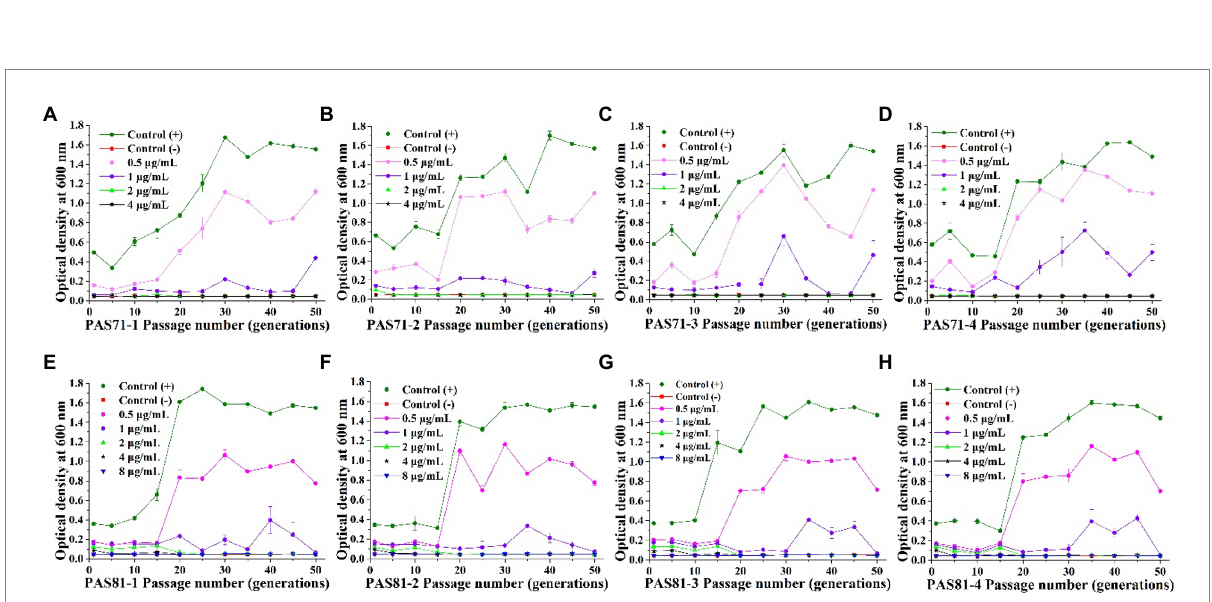
FIGURE 3 Curves of levofloxacin resistance of the four subpopulation isolates of PAS71 and PAS81 after 50 generations of subcultures without antibiotics. (A) PAS71-1; (B) PAS71-2; (C) PAS71-3; (D) PAS71-4; (E) PAS81-1; (F) PAS81-2; (G) PAS81-3; (H)